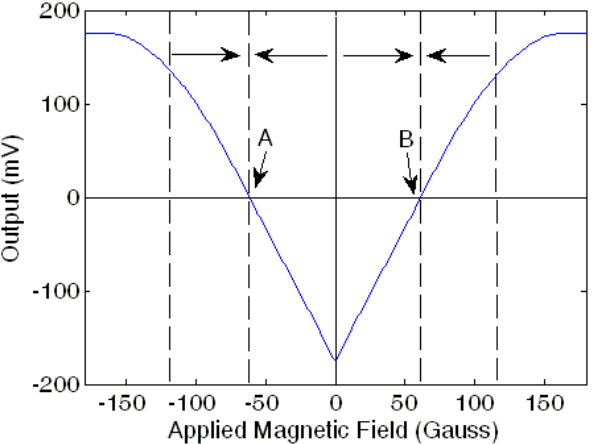
Figure 5. Offset output of the sensor.